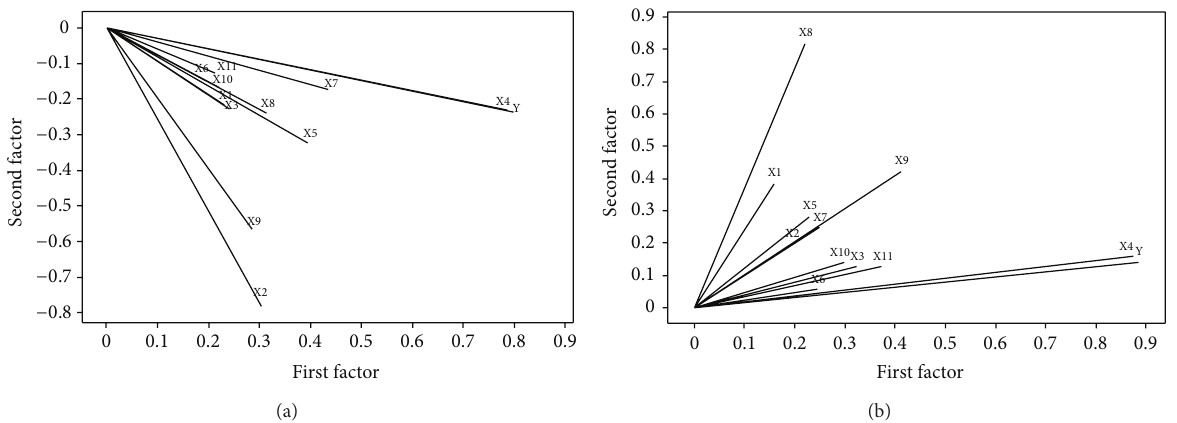
Figure 1: (a) Variables loading by factor analysis and varimax rotation with first two factors under inoculation condition and different water levels. X1: tiller numbers/plant, X2: spike length, X3: spikelets/spike, X4: spike weight/plant, X5: grain number/spike, X6: grain weight/spike, X7: 100-grain weight, X8: total chlorophyll content of flag leaf, X9: biological yield/plant, X10: root weight, X11: leaves area, and Y: grain yield. (b) Variables loading by factor analysis and varimax rotation with first two factors under noninoculation condition and different water levels. X1: tiller numbers/plant, X2: spike length, X3: spikelets/spike, X4: spike weight/plant, X5: grain number/spike, X6: grain weight/spike, X7: 100-grain weight, X8: total chlorophyll content of flag leaf, X9: biological yield/plant, X10: root weight, X11: leaves area, and Y: grain yield.